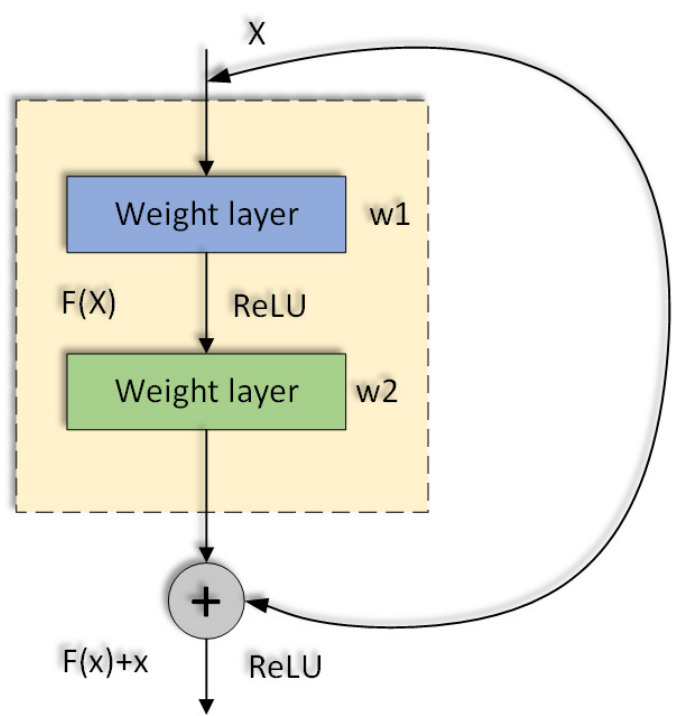
than F(x) = x and the change of parameters will be more stable. When the residual learning is in the shallow layer, the learning is linear superposition, and when it reaches the deep layer, F(x) will tend to zero, realizing the identity mapping so as to avoid the increase in layers affecting the learning results. At this time, on the premise of not affecting the learn- ing results, we can increase the number of network layers, extract more fine-grained fea- Figure 5. Residual block structure. Figure 5. Residual block structure. tures and obtain more small-target feature information.